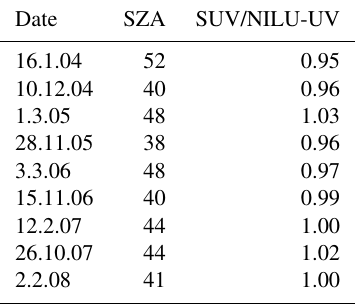
Table 2. The ratios of erythemally weighted UV dose rates between the reference NILU-UV and the SUV spectroradiometer during 2004–2006. For 2007–2008 the comparisons were done between the NILU-UV of Ushuaia and the SUV spectroradiometer. The date format is day.month.year (two digits).